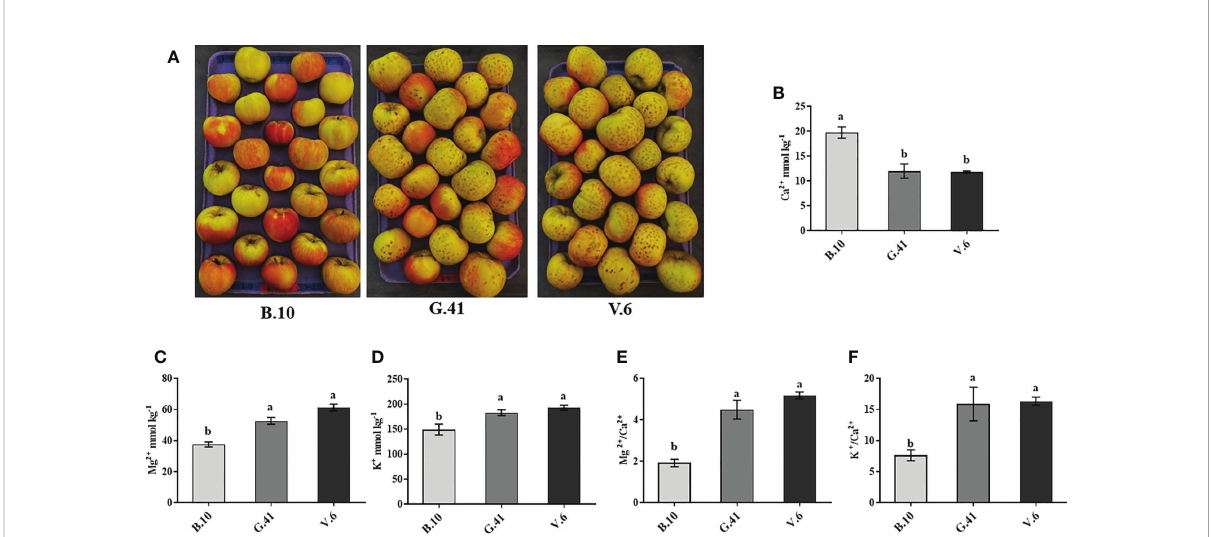
FIGURE 3 Variations in mineral nutrient concentrations in ‘ Honeycrisp ’ apples as affected by the rootstock. (A) Bitter pit (BP) symptom development on ‘ Honeycrisp ’ apples from B.10, G.41 and V.6 rootstocks after two months of cold storage. (B – D) concentration of calcium (Ca), magnesium (Mg) and potassium (K) and (E, F) , Mg/Ca and K/Ca ratios in ‘ Honeycrisp ’ apples ’ s skin tissues. Means not sharing any letter are signi fi cantly different at P < 0.05, according to Tukey ’ s HSD